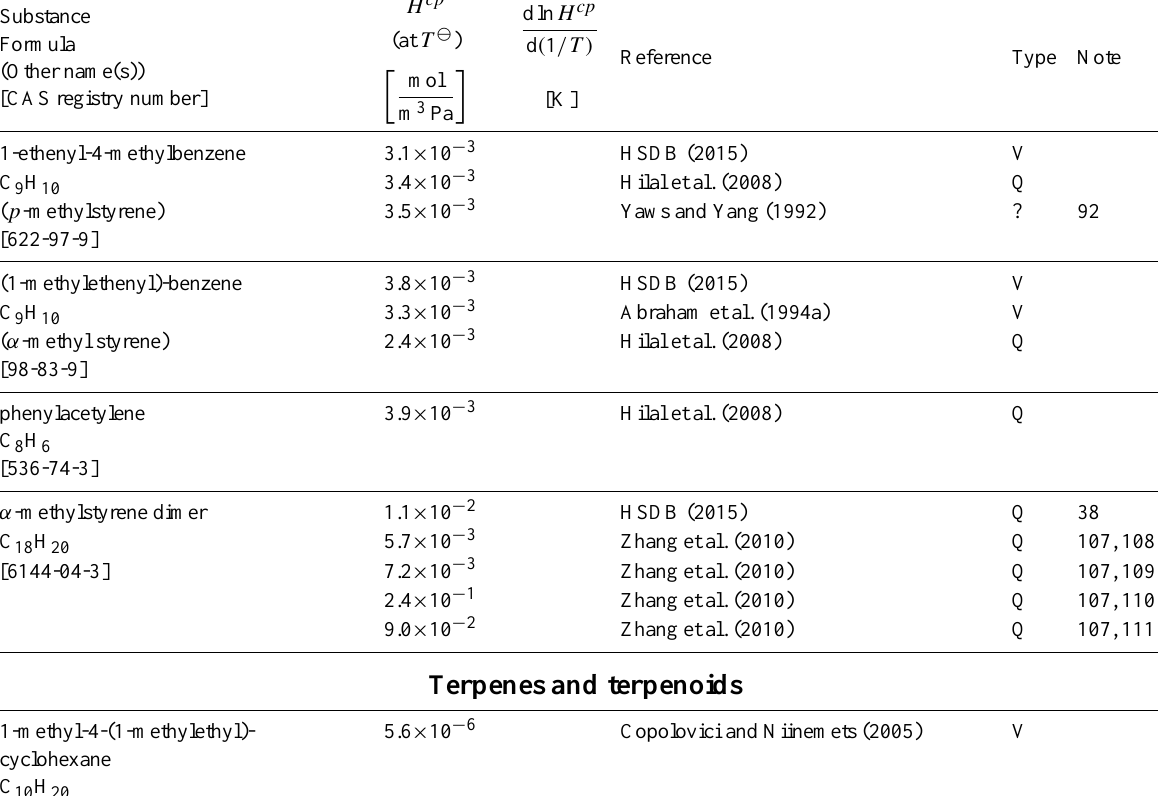
Table 6: Henry’s law constants for water as solvent